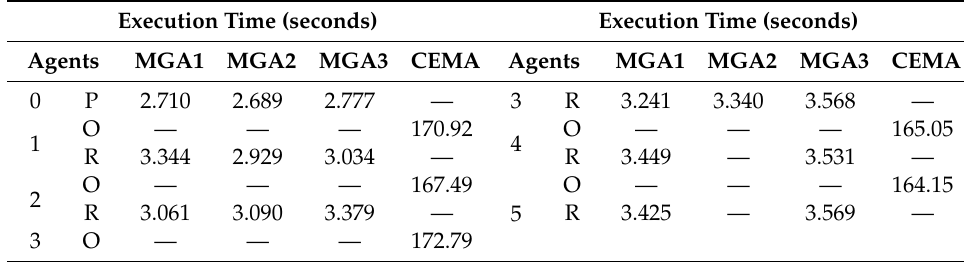
Table 7. Execution time during PORA.